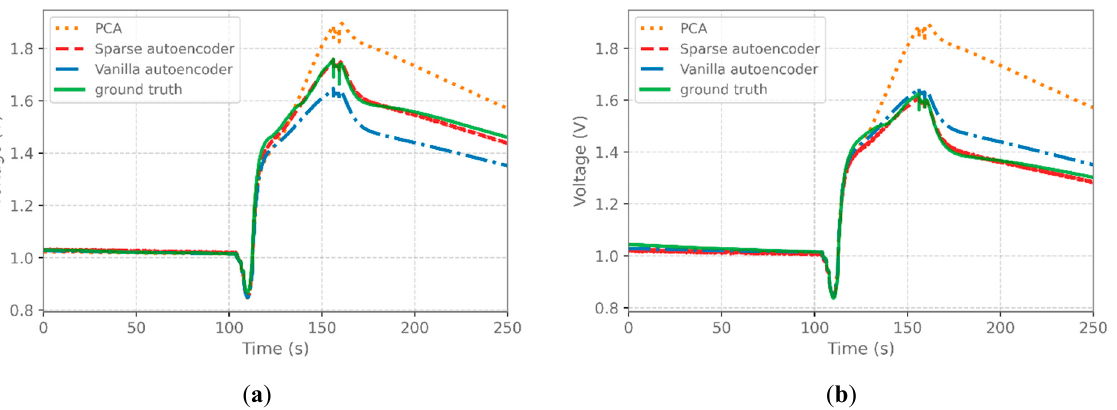
Figure 3. Comparison of reconstruction accuracy of SAE, AE, and PCA for gas mixture samples with